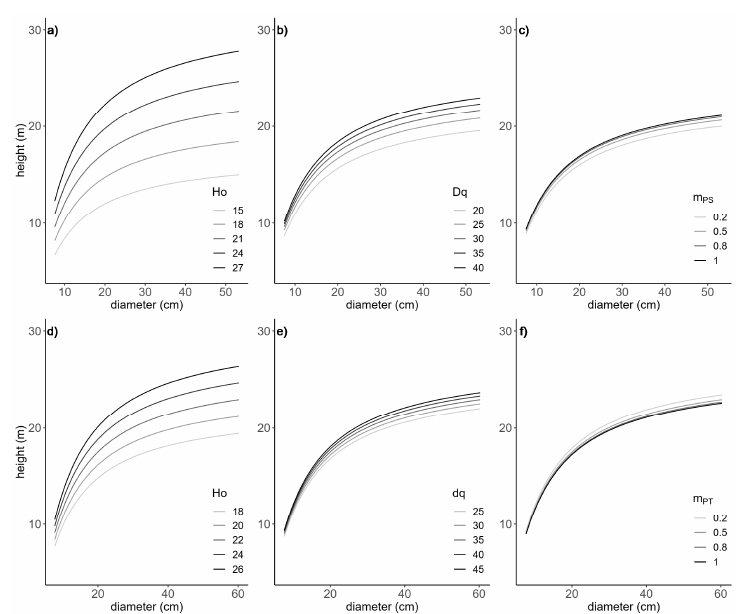
Figure 1. Effects of dominant height (Ho), quadratic mean diameter (dq), and species mixing proportion of target species ( m PS or m PT ) on the final h-d models in Equation (4) for Scots pine ( a – c ) and Maritime pine ( d – f ). Curves were produced using the parameter estimates in Table 2 and varying one explanatory variable at a time. Mean values of the data were used for predictors and the range of the variable of interest in the figure.